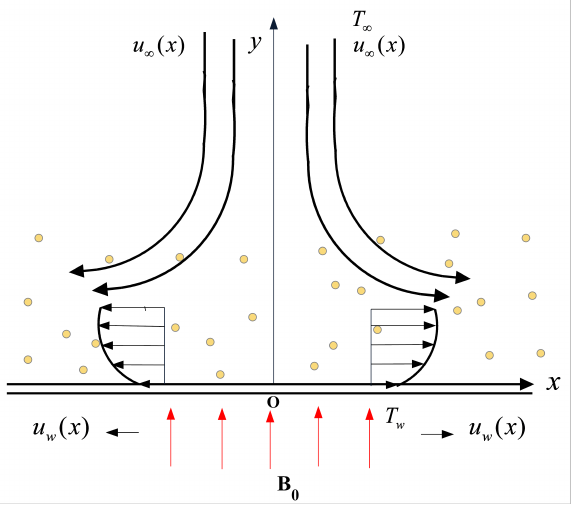
Fig. 1: Physical model and co-ordinate system for MHD nanofluid stagnation point